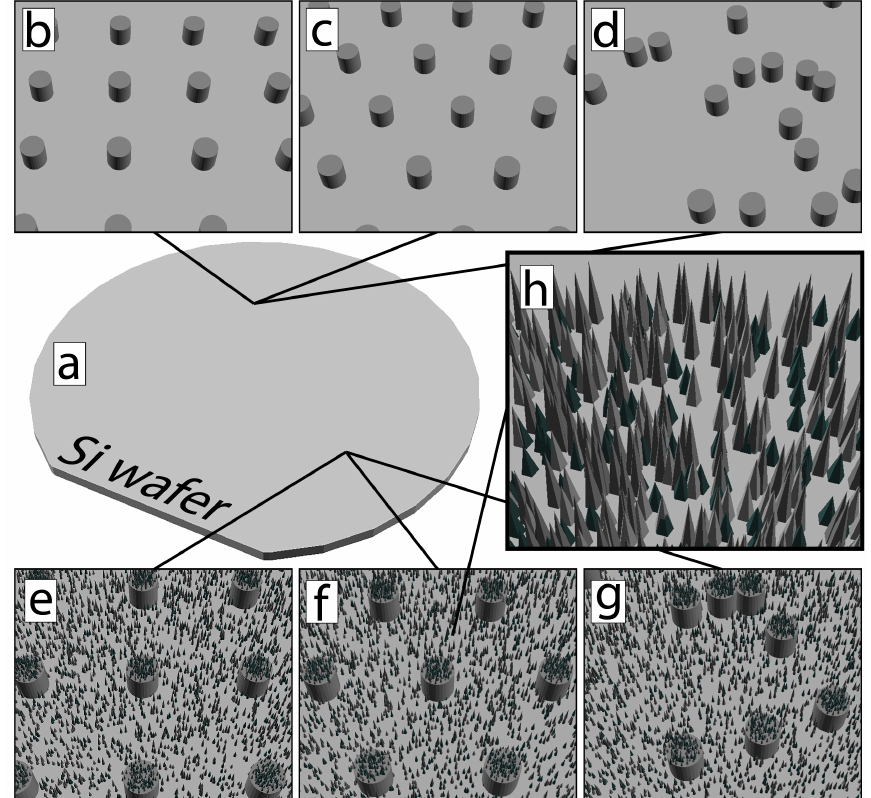
Figure 1. Schematic structures of studied micro- and nanotopography. ( a ) Planar silicon surface coated with either material. Microtopography with 2 µ m or 20 µ m (1:1 aspect ratio) pillars in ( b ) square-grid layout, ( c ) hexa-grid layout or ( d ) random-grid layout, either silicon coated with tetrahedral amorphous carbon (ta-C) or made entirely of pyrolytic carbon (PyC). ( e – g ) Same pillars but now nanoroughened with black silicon structures, so-called “dual-scale” structure. ( h ) Nanoroughness in the form of black silicon structures (small pyramid-like spikes in random pitch and